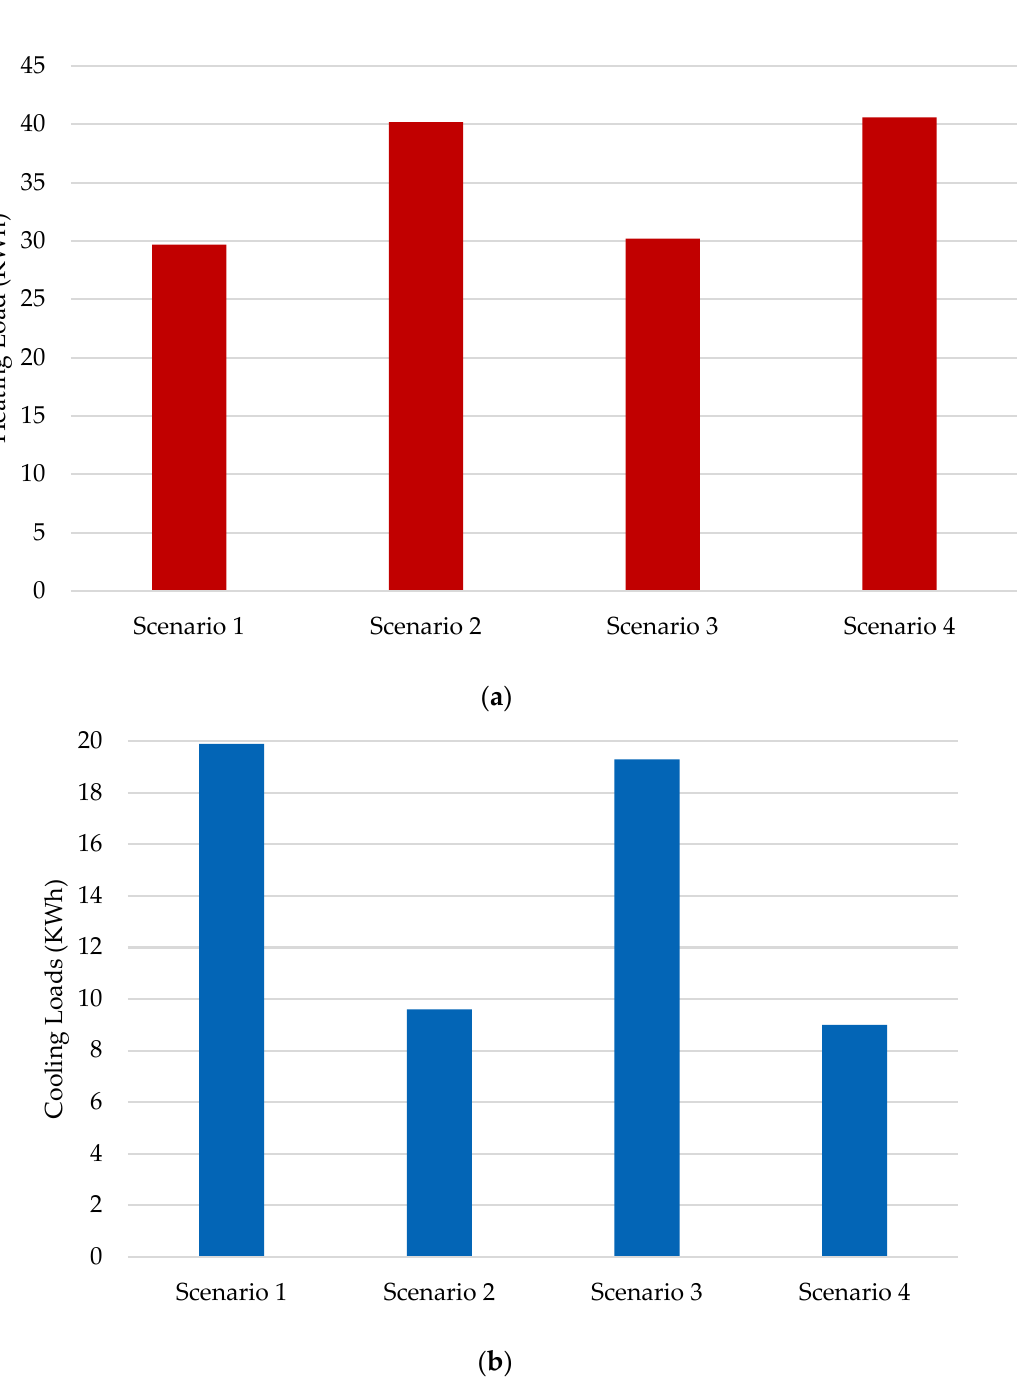
Figure 17. ( a ) Heating and ( b ) cooling building energy loads for a day in the selected office space based on Scenarios 1–4.